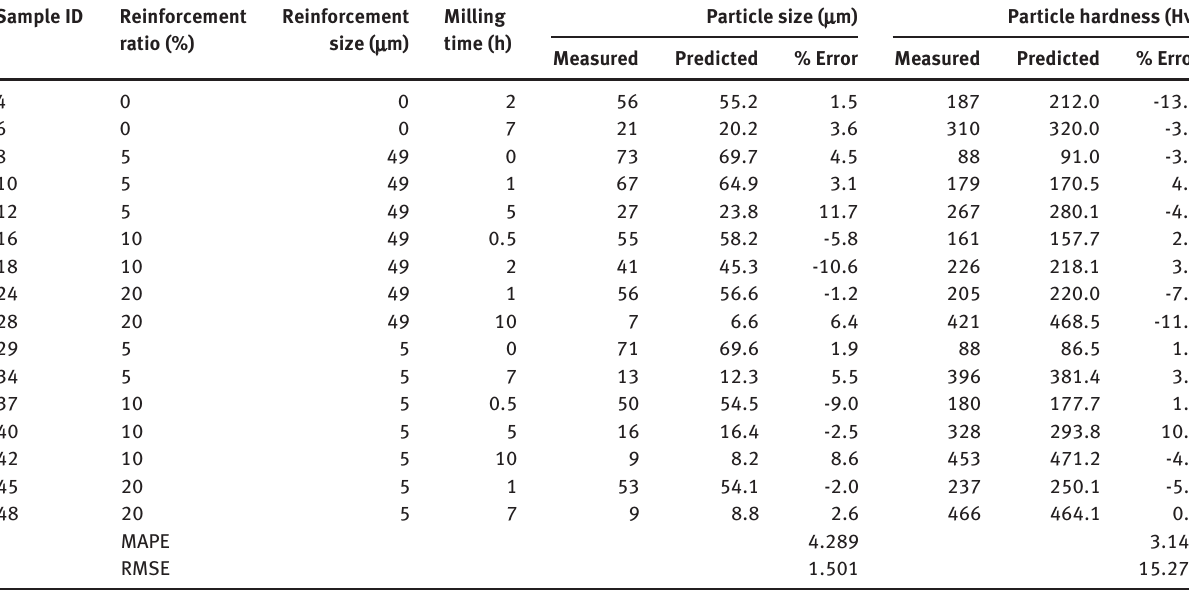
Table 3 Experimental data and predicted output from the ANN network for testing